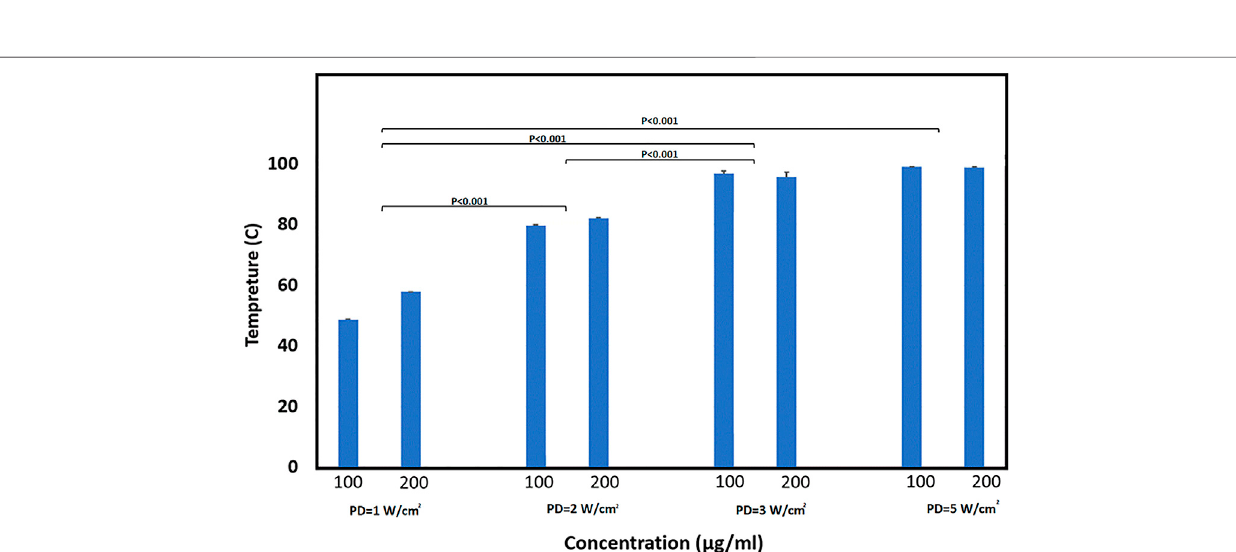
Frontiers in Nanotechnology |